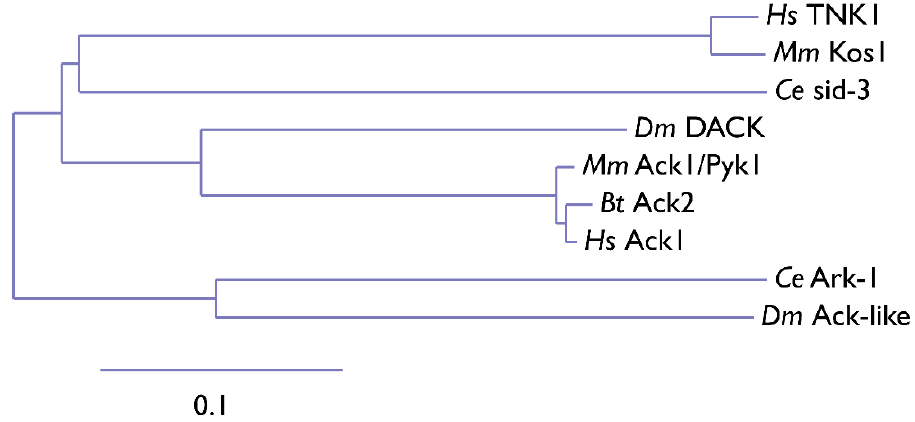
Figure 2. Phylogenetic tree of the Ack1 family. Ce, Caenorhabditis elegans (nematode); Dm, Drosophila melanogaster (fruit fly); Bt, Bos taurus (cow); Hs, Homo sapiens (human); Mm, Mus musculus (mouse). The scale indicates the rate of amino acid substitution per residue. The amino acid sequences of the kinase domains of Ack family proteins from C. elegans (sid-3, Ark-1), D. melanogaster (DACK, Ack-like), B. taurus (Ack2), M. musculus (Ack1, Kos1), and H. sapiens (Ack1, TNK1) were used for phylogenetic analysis. The phylogenetic tree was manually compiled using MAFFT, Gblocks, PhyML, and TreeDyn at Phylogeny.fr [17].